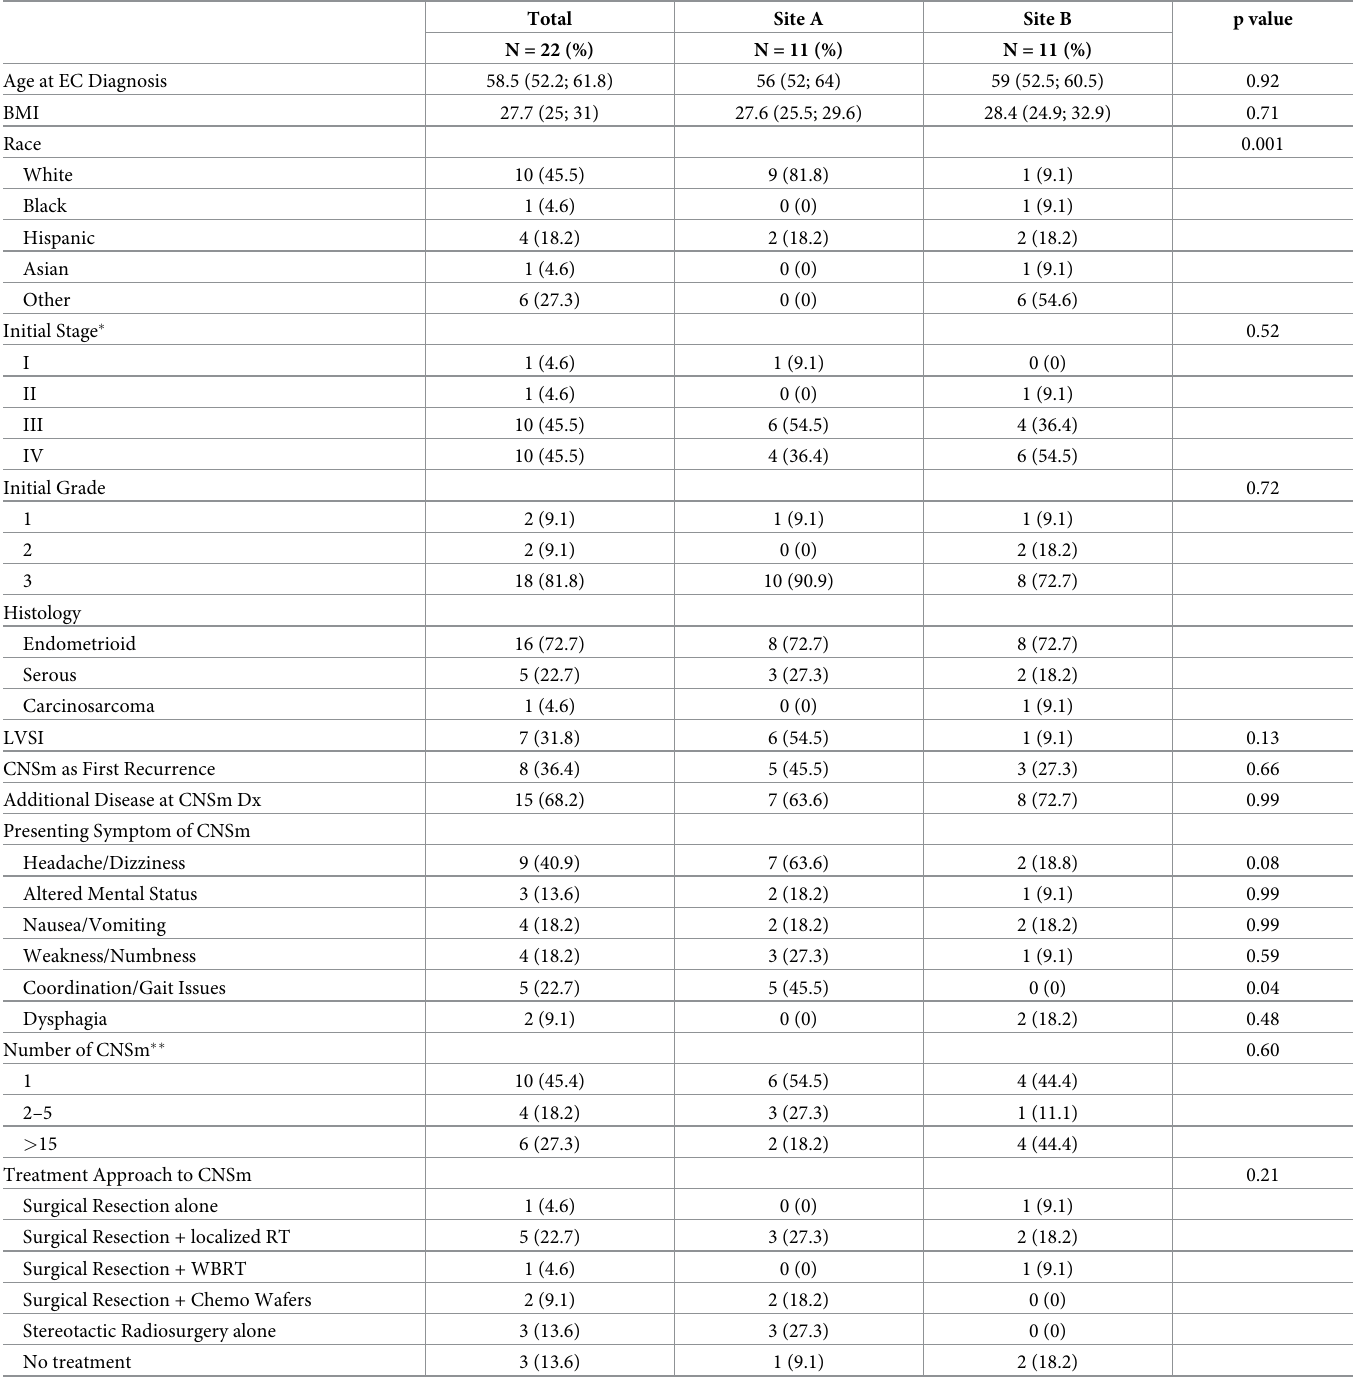
Table 1. Clinical and pathologic